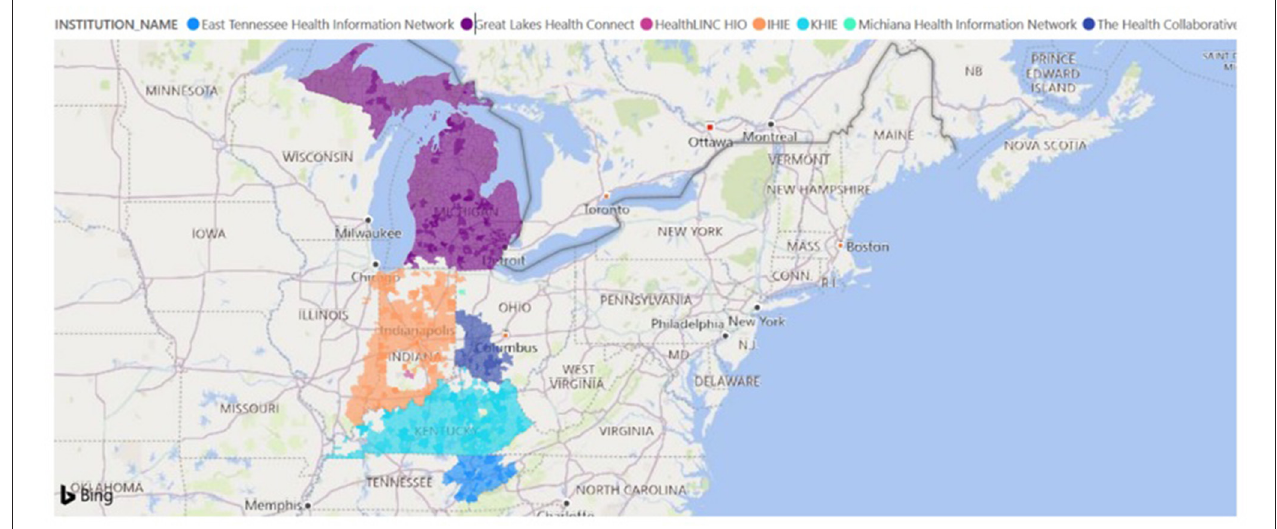
FIGURE 4 | Overlap analysis of heartland region HIE zip codes.